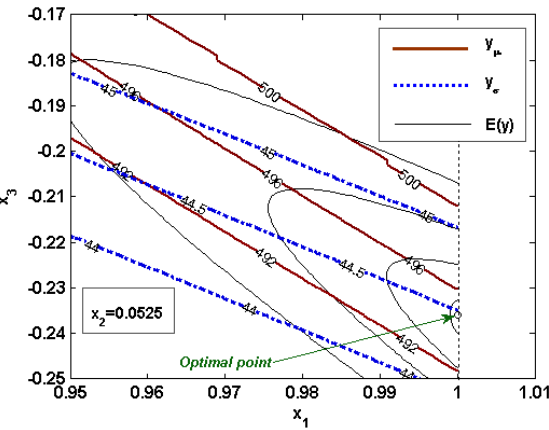
Figure 13. Contour plot for the estimated mean and standard deviation for Example